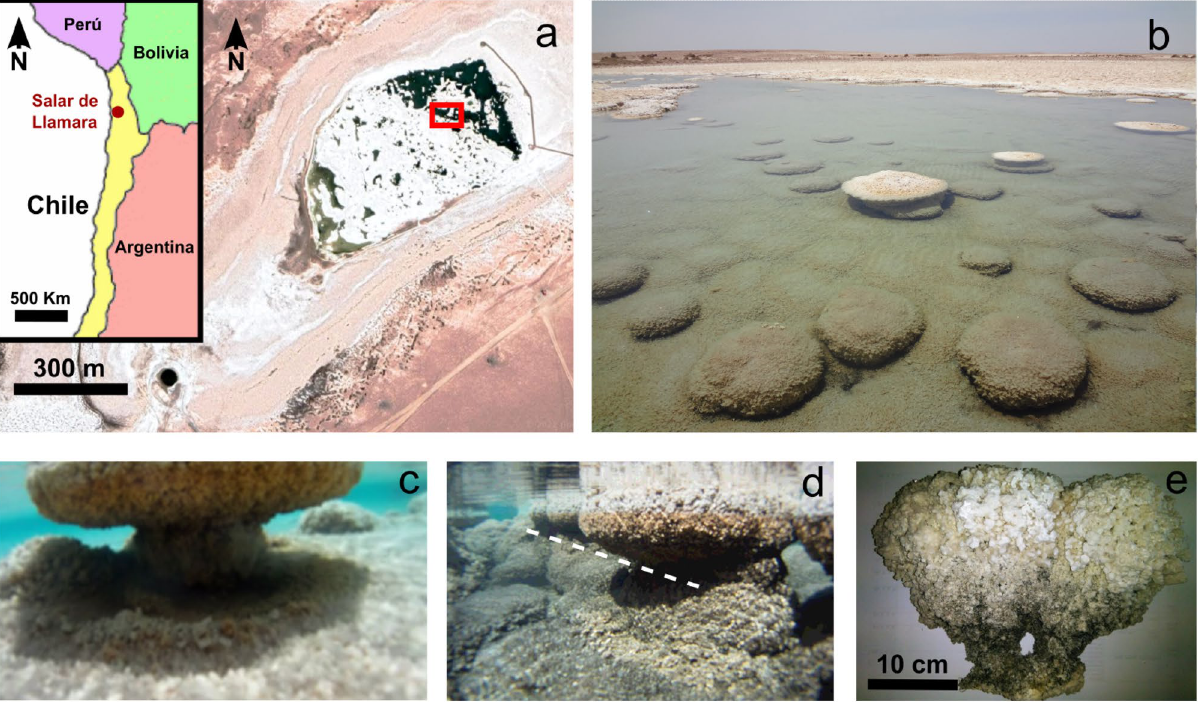
Figure 1. Gypsum stromatolite-like structures at the Huatacondo ponds locally named puquíos . ( a ) Location of the Salar de Llamara near the Pacific Coast of South America (inset) and Google Earth (2019) satellite image of the Puquíos de Huatacondo in the Llamara Salar, Atacama Desert, Chile. Red square is the location where photo ( b ) was taken. ( b ) Overall view of the gypsum stromatolite-like structures (GSLS) in a shallow puquío . ( c ) Lateral view of an in situ structure showing its characteristic mushroom shape and the accumulation of detrital gypsum particles under the GSLS. ( d ) In situ lateral view of a group of depth-aligned GSLS with narrow sections at the same depth (white dashed line). Detrital gypsum particles are also observed under the structures. ( e ) Lateral view of the studied GSLS (external surface). The size of GSLS shown in ( c ) and ( d ) are similar to the GSLS shown in ( e ). Additional images are available in Supplementary Figs. S1 and